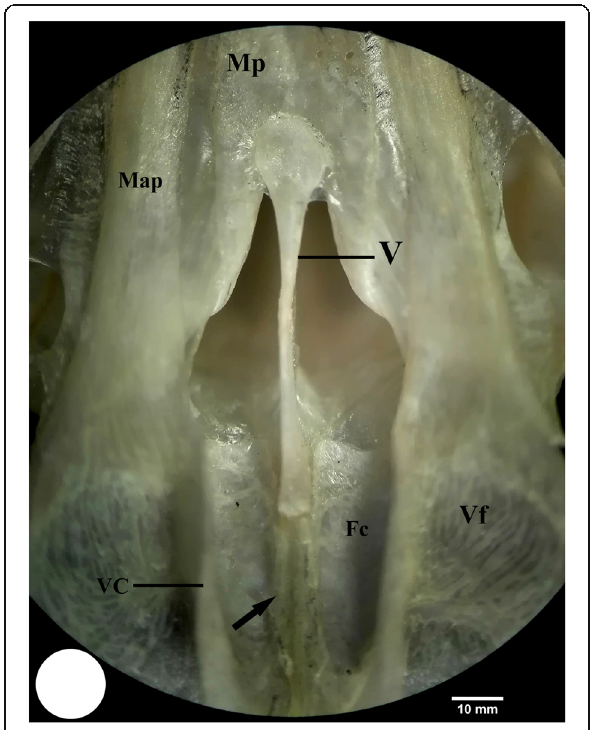
Fig. 8 High magnification of ventral surface of skull of kestrel shows the maxillary process of the palatine bone (Map), maxillopalatine process (MP), vomer bone (V), choana fossa (Fc), medial crest (arrow), ventral crest (Vc), and ventral fossa